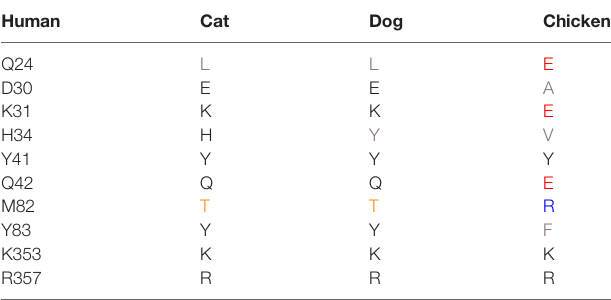
The table shows key residues involved in the binding of the human ACE2 with the viral RBD. The structure showed key residues that form a set of polar contacts (as well as one hydrophobic contact) with the viral RDB, hence stabilizing the complex. Substitutions that increase the hydrophobicity and polarity of the binding surface with respect to the human receptor are depicted in gray and orange fonts, respectively. Whereas substitutions that increase negative and positive charge are depicted in red and blue fonts,